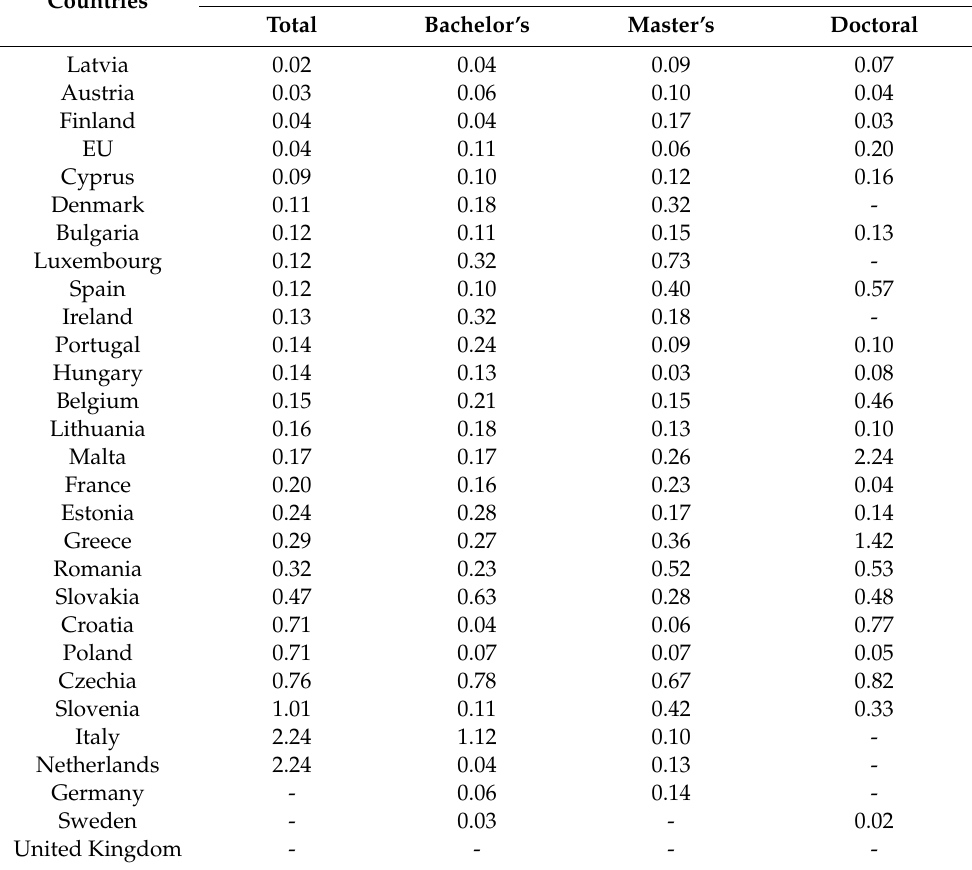
Table 3. Coe ffi cients of variation for the number of students studying electricity and energy in EU countries in